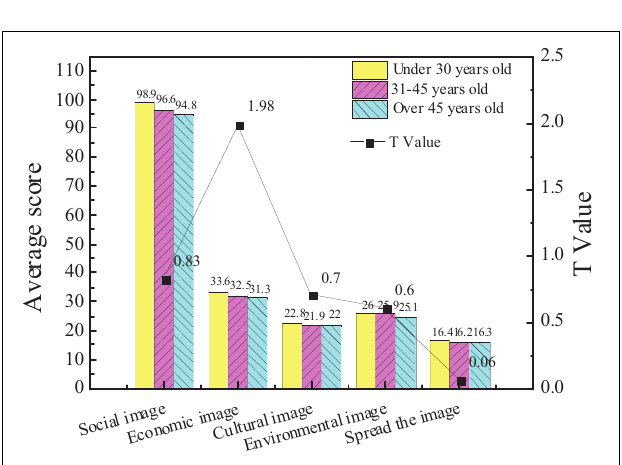
FIGURE 3 | Comparison of the attention of the entrepreneurs of different ages to the city image.